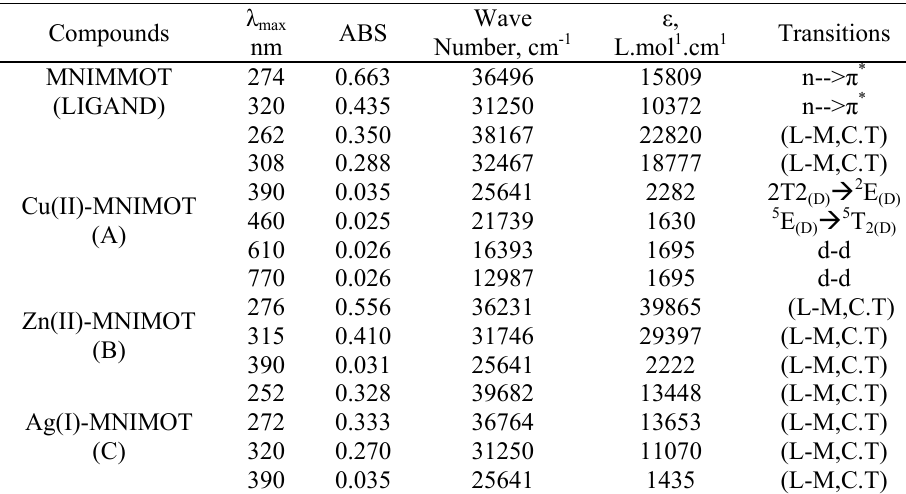
Table 6. UV-Vis Spectra of free ligand and its metal complexes in 10 -5 M solution in DMSO